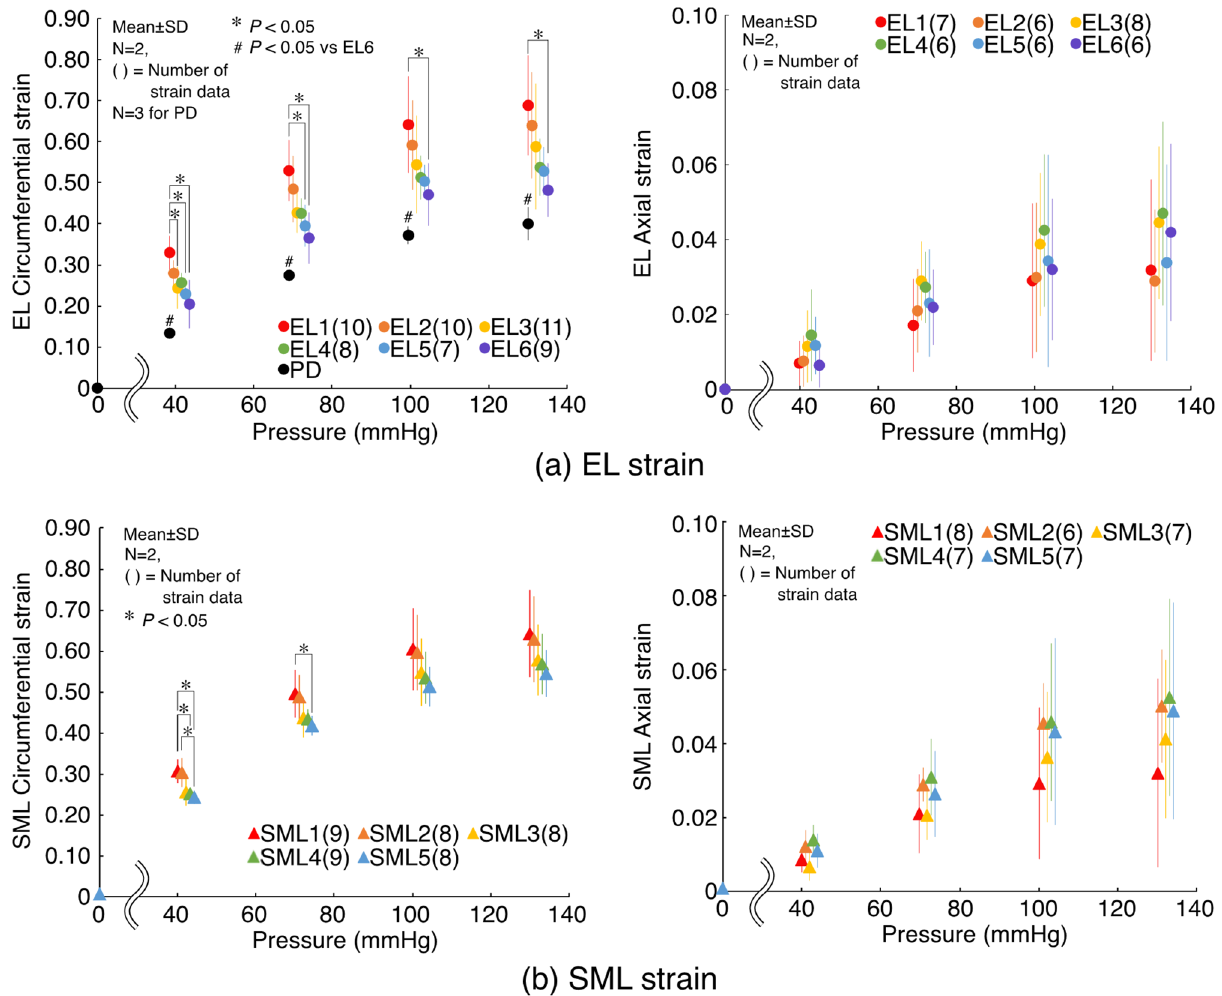
Figure 8. Circumferential (left) and axial (right) strain during pressurization in each layer of ( a ) ELs and ( b ) SMLs obtained from dynamic two-photon microscopy. PD in the plot of EL circumferential strain indicates the circumferential strain simply calculated from the changes in the apparent diameter during the pressure- diameter test results. N, number of specimens. Statistical analysis was performed for strain data indicated in the round